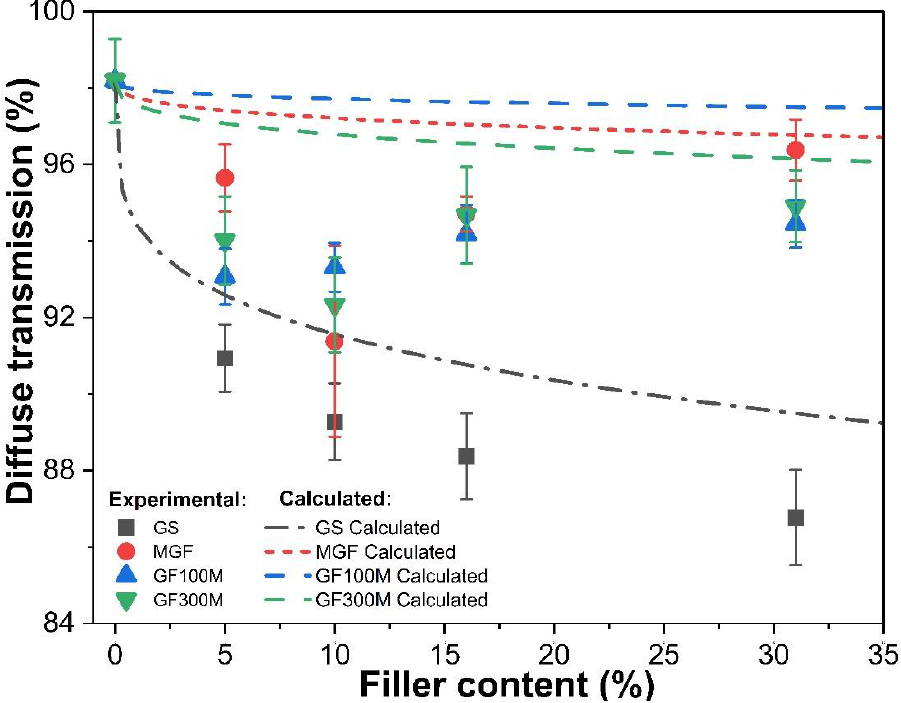
Figure 8. Concentration dependances of diffuse transmittance of TPU with different fillers.